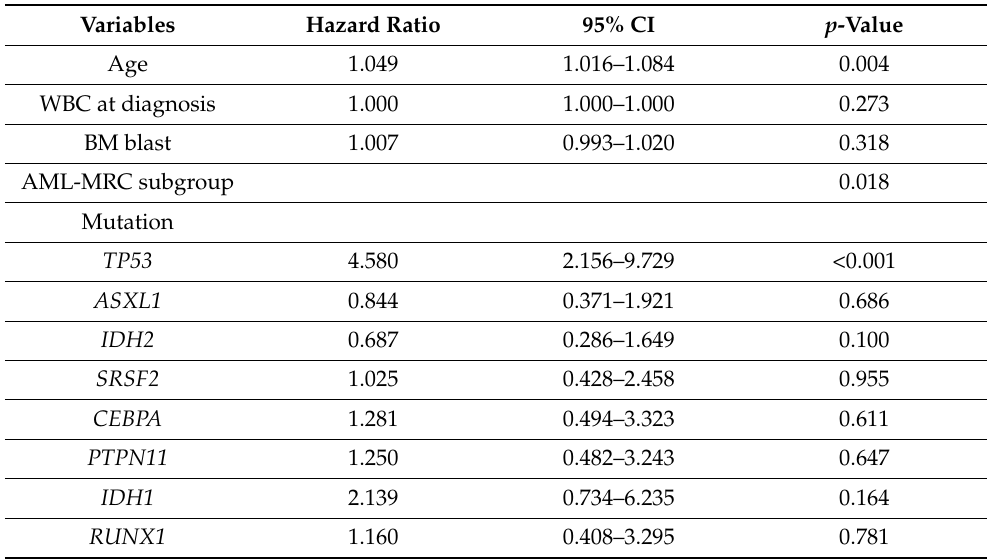
Figure 2. Overall survival of all patients according to AML-MRC subtype ( a ) in all patients, ( b ) among treated patients, and ( c ) among patients who underwent intensive chemotherapy. Table 2. Overall treatment outcomes: univariate